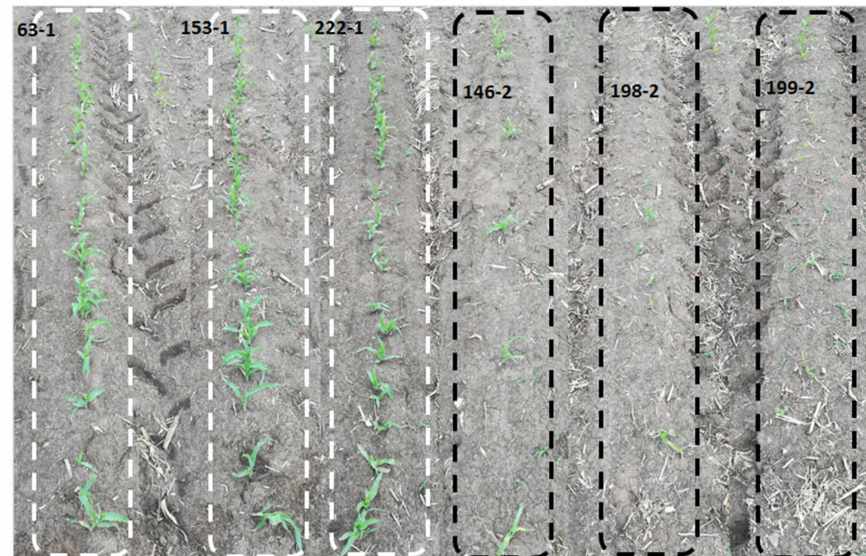
Figure 1. Maize seedling performance under cold stress. The performances were based on seedling survival rates and visual observations of the seedling leaves. The white and black dotted lines represent the cold-tolerant and cold-sensitive lines, respectively. The majority of the tolerant lines maintained a strong vigor with higher survival rates, while most of the sensitive line died, and their leaves had yellowish